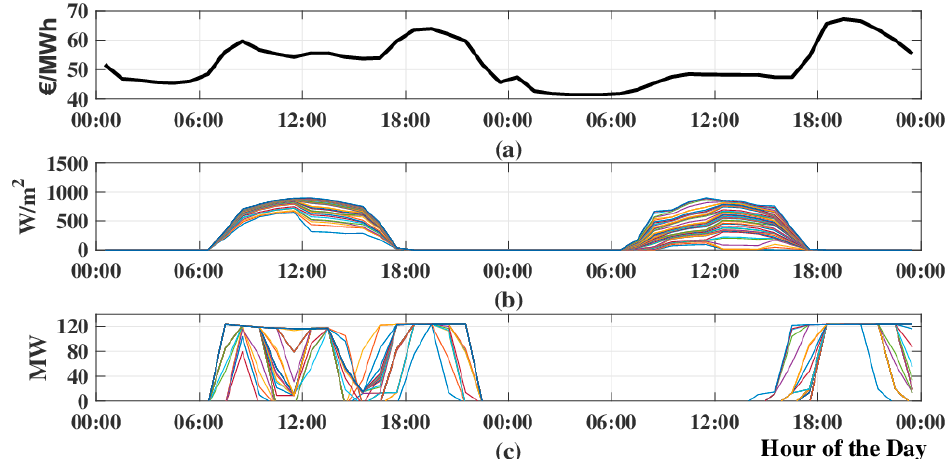
Figure 4. Financial profile ( a ), resource probabilistic forecast ( b )—direct normal irradiation, which is the relevant resource for CSP systems—and forecasted (optimized) electricity delivery schedules ( c ) for two example days.